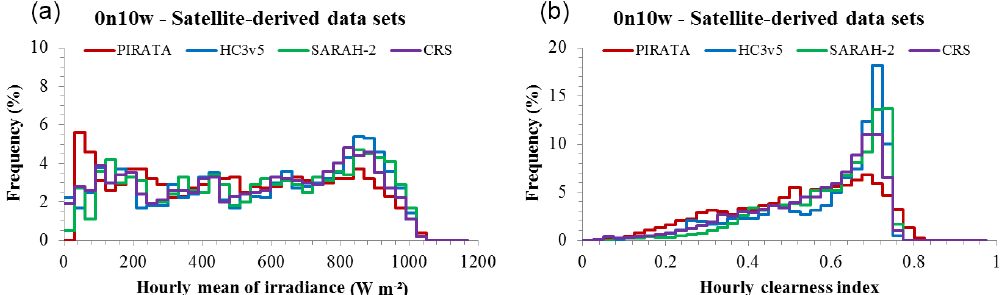
Figure B2. Frequency distributions of PIRATA measurements (red) and data sets (HC3v5: blue, SARAH-2: green, CRS: purple) at 0 ◦ N, 10 ◦ W for E (a) and KT (b) . If the coloured line is above (below) the red one for a given sub-range of values, it means that the data set produces these values too frequently (too rarely) with respect to the PIRATA measurements.